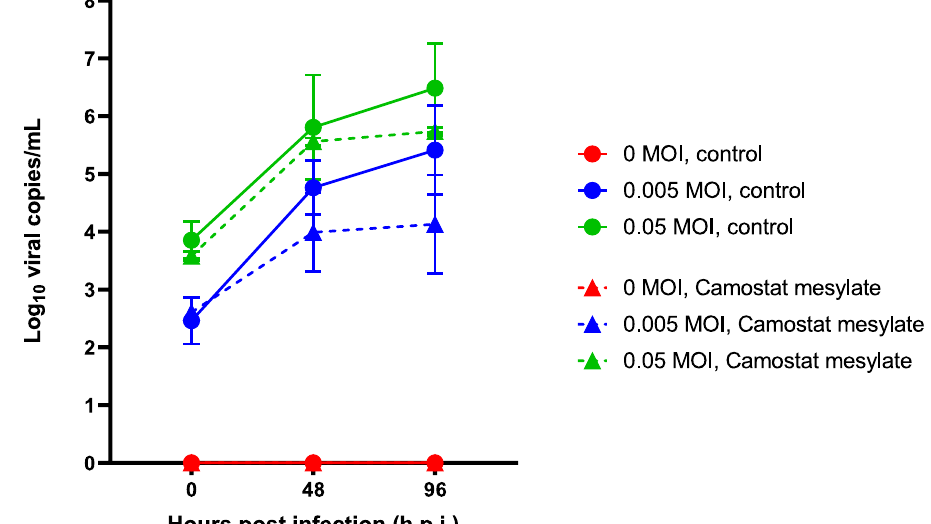
Figure 10. Efficacy of camostat mesylate against hCOV-NL63-inoculated PREDICT96-ALI airway tissue. RT-qPCR analyses for viral copies in the apical wash of PREDICT96-ALI airway tissue at 0, 48 and 96 h p.i. with HCoV-NL63 across multiple MOIs. Solid lines show viral copies for MOI 0 (red, mock control), MOI 0.005 (blue) and MOI 0.05 (green) when treated with vehicle (DMSO), and dashed lines show corresponding viral copies when treated with 20 µM camostat mesylate. N = 2–4 tissue replicates per donor, time-point and condition. Replicates that did not meet the minimum signal intensity after 45 PCR cycles are displayed along the